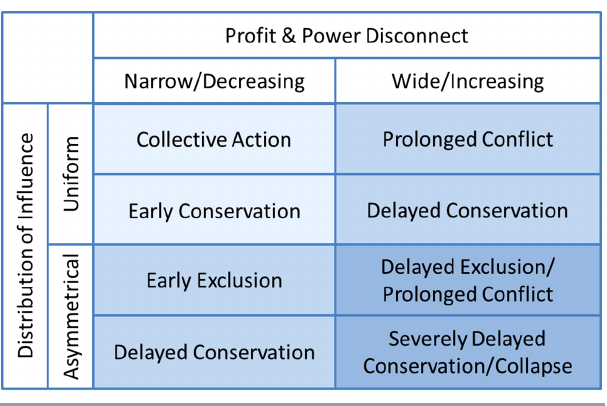
Fig. 4 . Predicted responses when fishers are the only powerful